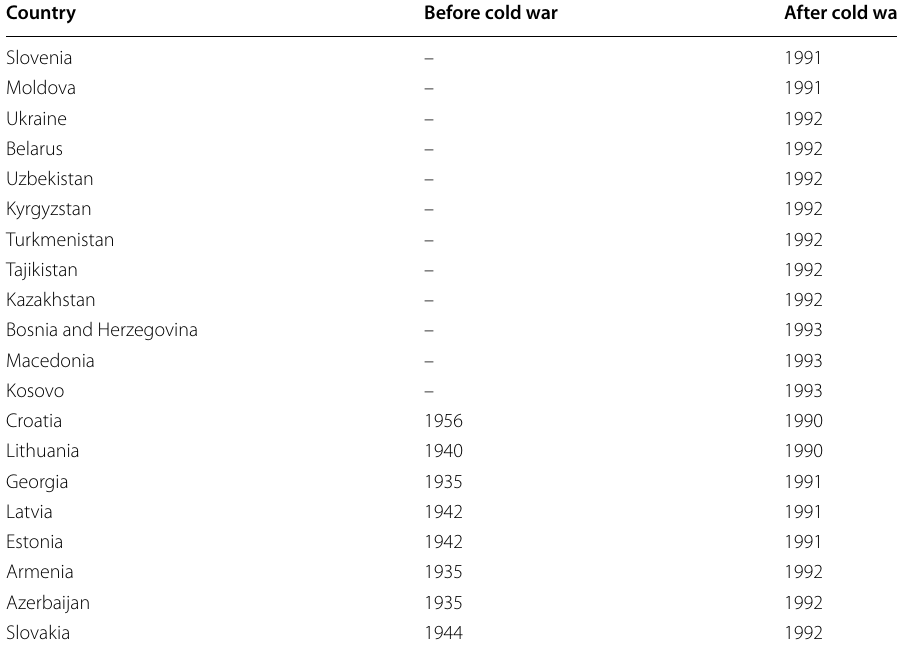
Table 6 Network nodes emerged after cold war